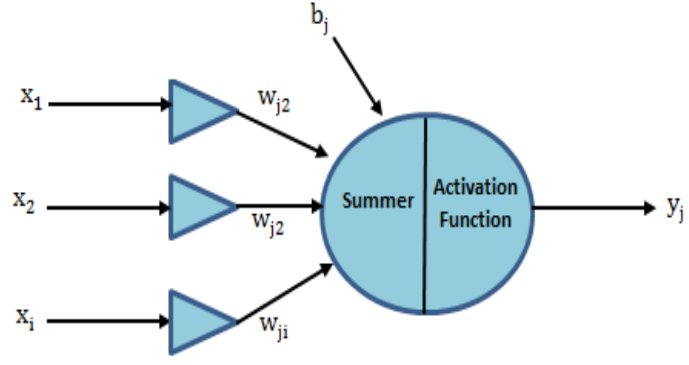
Figure 2. The single neuron model.